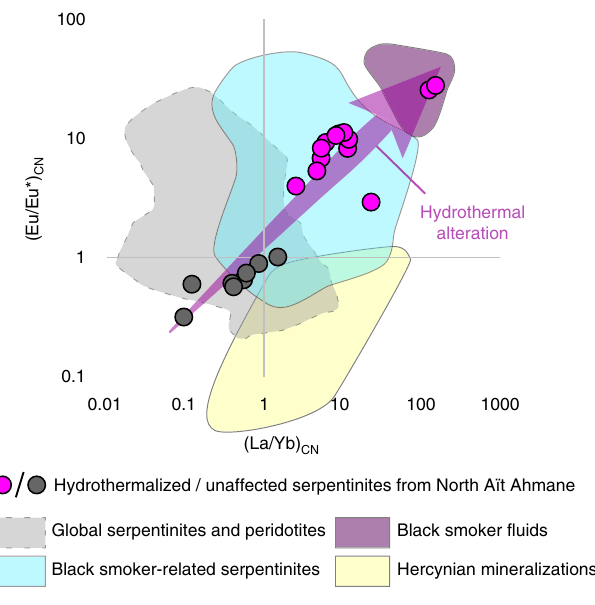
Fig. 2 (Eu/Eu*) CN ratio vs. (La/Yb) CN ratio in North Aït Ahmane serpentinites. Data are compared with global serpentinites and peridotites 28,61,62,64,65 (in gray) and with black smoker-related serpentinites 21 – 24 (in blue). Correlated enrichment in LREE and Eu in hydrothermalized serpentinites from Aït Ahmane tends toward those of black smoker fl uids sampled at the sites of Rainbow 19 , Logatchev 19 , and Manus basin 20 (in purple). Carbonates hosting tardi-orogenic mineralizations in Bou Azzer inlier, dated at 310 ± 5 Ma 30 , plot in a clearly different fi eld (in yellow), discarding a post-obduction process 18 for Eu and LREE enrichments in the serpentinites. Chondrite normalization values are from Barrat et al.